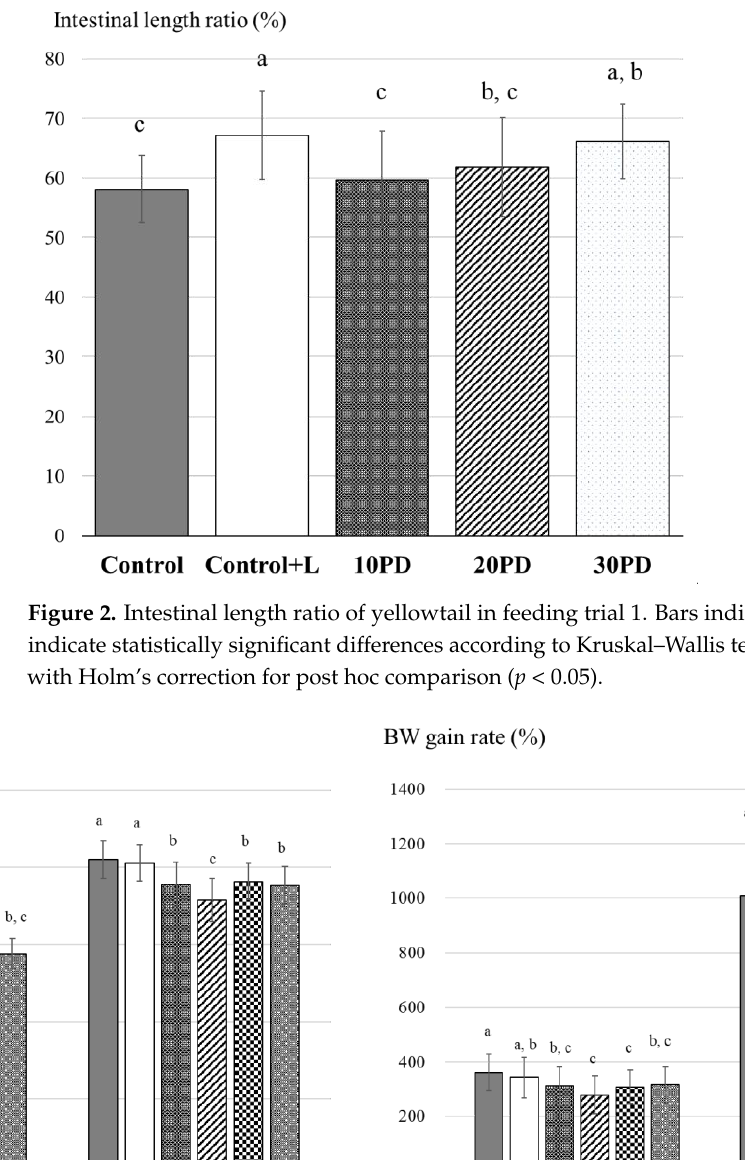
Table 7. Growth of juvenile yellowtail in feeding trial 2.